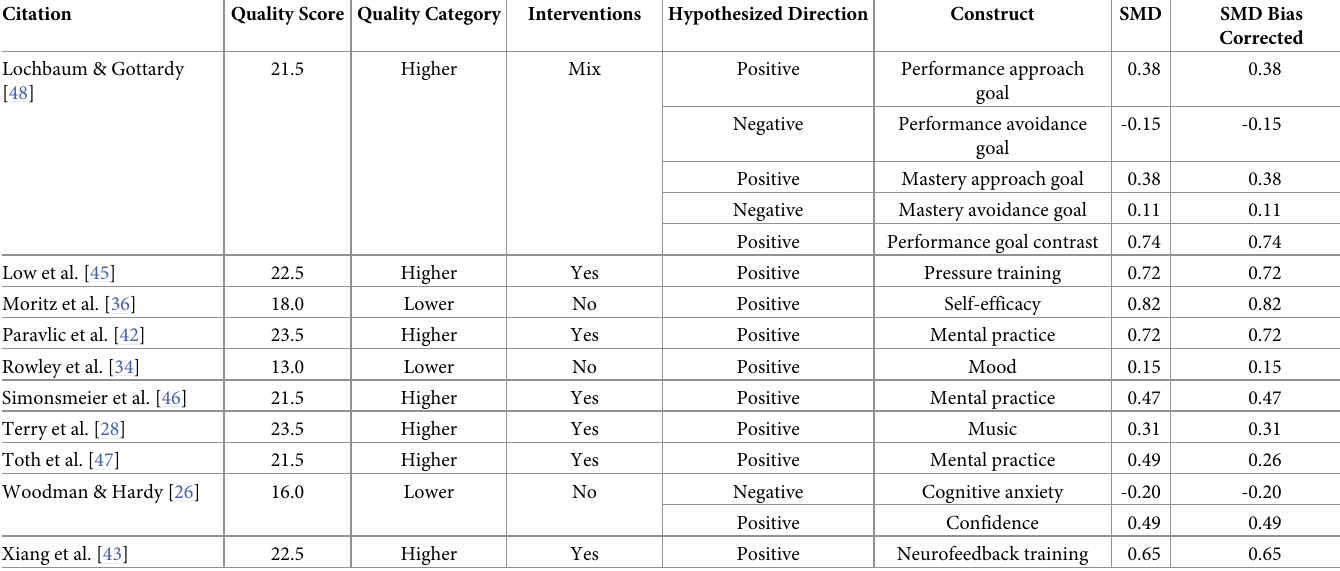
moderate ( ± 0.50 to < 0.80), 2 as large ( ± 0.80 to < 1.30), and 1 as very large ( � 1.30). Study quality rating results and summary analyses Following our PRISMA quality ratings, intercoder reliability coefficients were initially .83 (ML, AL), .95 (ML, PT), and .90 (AL, PT), with a mean intercoder reliability coefficient of .89. To achieve improved reliability (i.e., r > .90), ML and AL re-examined their ratings. As a result, intercoder reliability increased to .98 (ML, AL), .96 (ML, PT), and .92 (AL, PT); a mean intercoder reliability coefficient of .95. Final quality ratings (i.e., the mean of two coders) ran- ged from 13 to 25 ( M = 19.03 ± 4.15). Our median split into higher ( M = 22.83 ± 1.08, range 21.5–25, n = 15) and lower ( M = 15.47 ± 2.42, range 13–20.5, n = 15) quality groups produced significant between-group differences in quality ( F = 115.62, p < .001); hence, the median 1,28 split met our intended purpose. The higher quality group of meta-analyses were published from 2015–2021 (median 2018) and the lower quality group from 1983–2014 (median 2000). It appears that meta-analysis standards have risen over the years since the PRISMA criteria were first introduced in 2009. All data for our analyses are shown in Table 2. Table 3 contains summary statistics with bias-corrected values used in the analyses. The overall mean effect for sport psychology constructs hypothesized to have a positive impact on performance was of moderate magnitude ( d = 0.51, 95% CI = 0.42, 0.58, n = 36). The overall mean effect for sport psychology constructs hypothesized to have a negative impact on perfor- mance was small in magnitude ( d = -0.21, 95% CI -0.31, -0.11, n = 24). In both instances, effects were larger, although not significantly so, among meta-analyses of higher quality com- pared to those of lower quality. Similarly, mean effects were larger but not significantly so, where reported effects in the original studies were based on interventional rather than correla- tional designs. This trend only applied to hypothesized positive effects because none of the original studies in the meta-analyses related to hypothesized negative effects used interven- tional